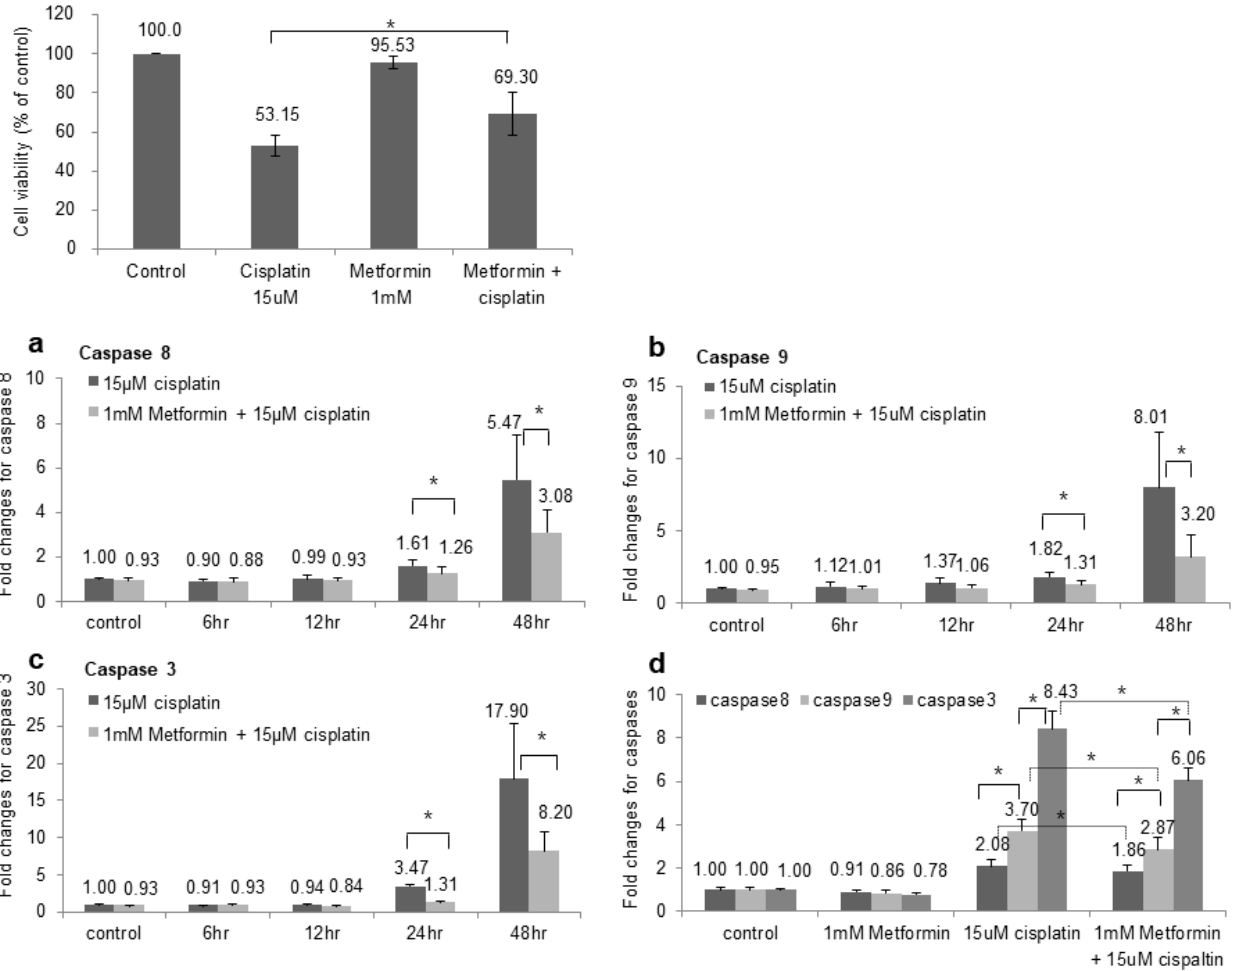
Figure 1. Change of Cell viability and Caspase activity after metformin pretreatment. ( A ) The cell viability was 53.15% when HEI-OC1 cells were exposed to cisplatin for 48 h. However, the cell viability increased to 69.30% when HEI-OC1 was pretreated with metformin for 24 h prior to application of cisplatin. ( B ) ( a ) Caspase 8 activity started to increase at 24 h (1.61-fold change) after the cisplatin application and significantly increased after 48 h (5.47-fold change). Metformin pretreatment reduced the activity of caspase 8 in both 24 h (1.26-fold change) and 48 h (3.08-fold change) and these were statistically significant. * p < 0.05. ( b ) Caspase 9 activity was increased to 1.82-fold change at 24 h and 8.01-fold change at 48 h after the cisplatin application. Metformin pretreatment reduced the activity of caspase 9 in both 24 h (1.31-fold change) and 48 h (3.20-fold change) and these were statistically significant. ( c ) Caspase 3 activity was increased to 3.47-fold change at 24 h and 17.90-fold change at 48 h after the cisplatin application. Metformin pretreatment reduced the activity of caspase 3 in both 24 h (1.31-fold change) and 48 h (8.20-fold change) and these were statistically significant. ( d ) When we compared the activity level of caspase 8, 9 and 3, they were increased to 2.08-, 3.70- and 8.43-fold change, respectively, after application of cisplatin for 48 h. The activity level of all three caspases were decreased to 1.86-, 2.87-, and 6.06-fold change after the pretreatment with metformin for 24 h (n =